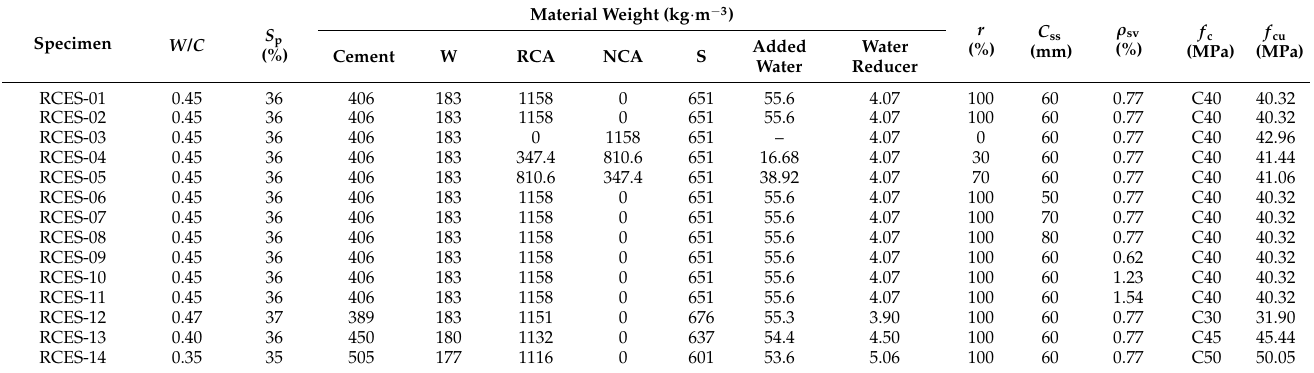
Table 2. Mix property and design details of test